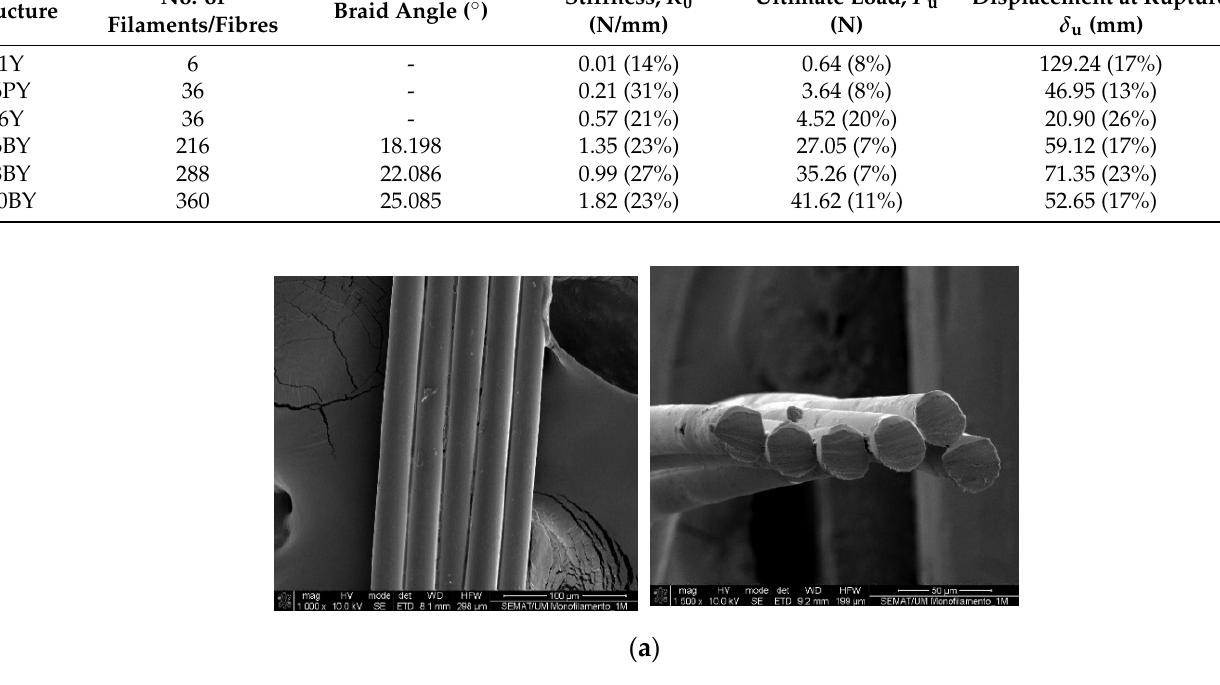
Table 1. Results obtained in tensile tests with the adopted PVA architectures. Values in parenthesis represent the coefficient of variation in percentage. Structure